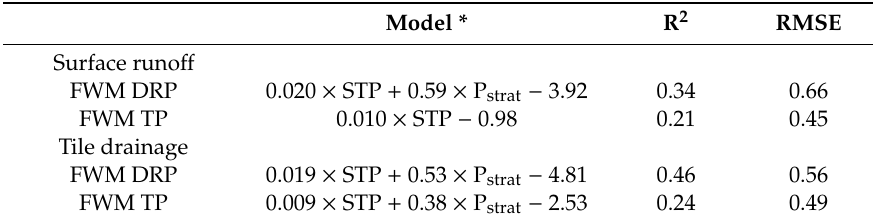
Table 4. Multiple linear regression results predicting edge-of-field FWM P concentrations with agronomic soil test P (STP) and P stratification ratio (P strat ). Regressions were performed on natural log transformed FWM P concentrations.